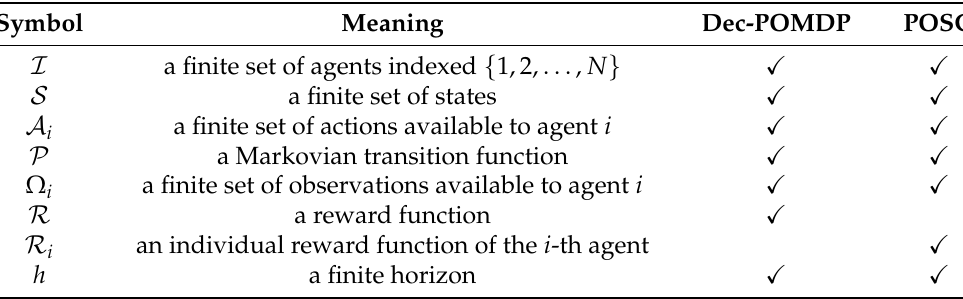
Table 1. Symbols in the Dec-POMDP and